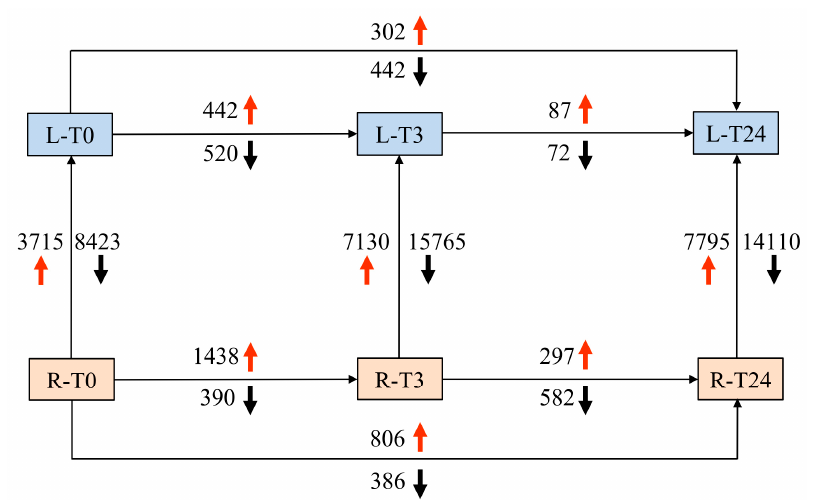
Figure 2. Summary of Di ff erentially Expressed Genes (DEGs) between organs and treatment duration.